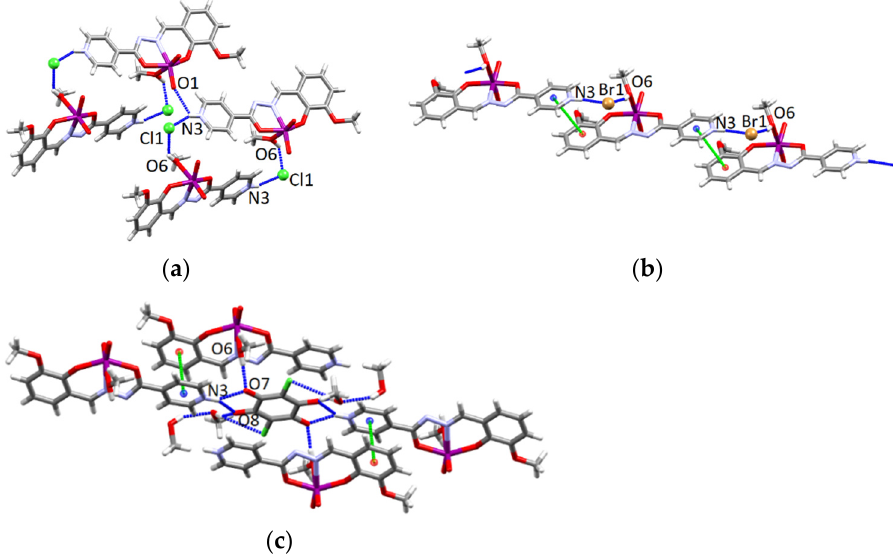
Figure 4. ( a ) Two dimers in [1H]Cl ·MeOH formed through N3–H3 ⋯ Cl1 and O6–H61 ⋯ Cl1 hydro- gen bonds and connected by N3 − H3 ⋯ O1 hydrogen bond, ( b ) Infinite 1D chain in [1H]Br formed through O6 − H61 ⋯ Br1 and N3 − H3 ⋯ Br1 hydrogen bonds, ( c ) 2D network in [1H](ClA) 0.5 ·2MeOH formed by N3–H3 ⋯ O7, N3–H3 ⋯ O8, O6 − H6 ⋯ O7 hydrogen bonds. Hydrogen bonds are shown by blue dotted lines. Green dashed lines indicate π - stacking interactions (Cg3 is centre of gravity of the pyridyl ring, blue spheres and Cg4 is centre of gravity of the phenyl ring, red